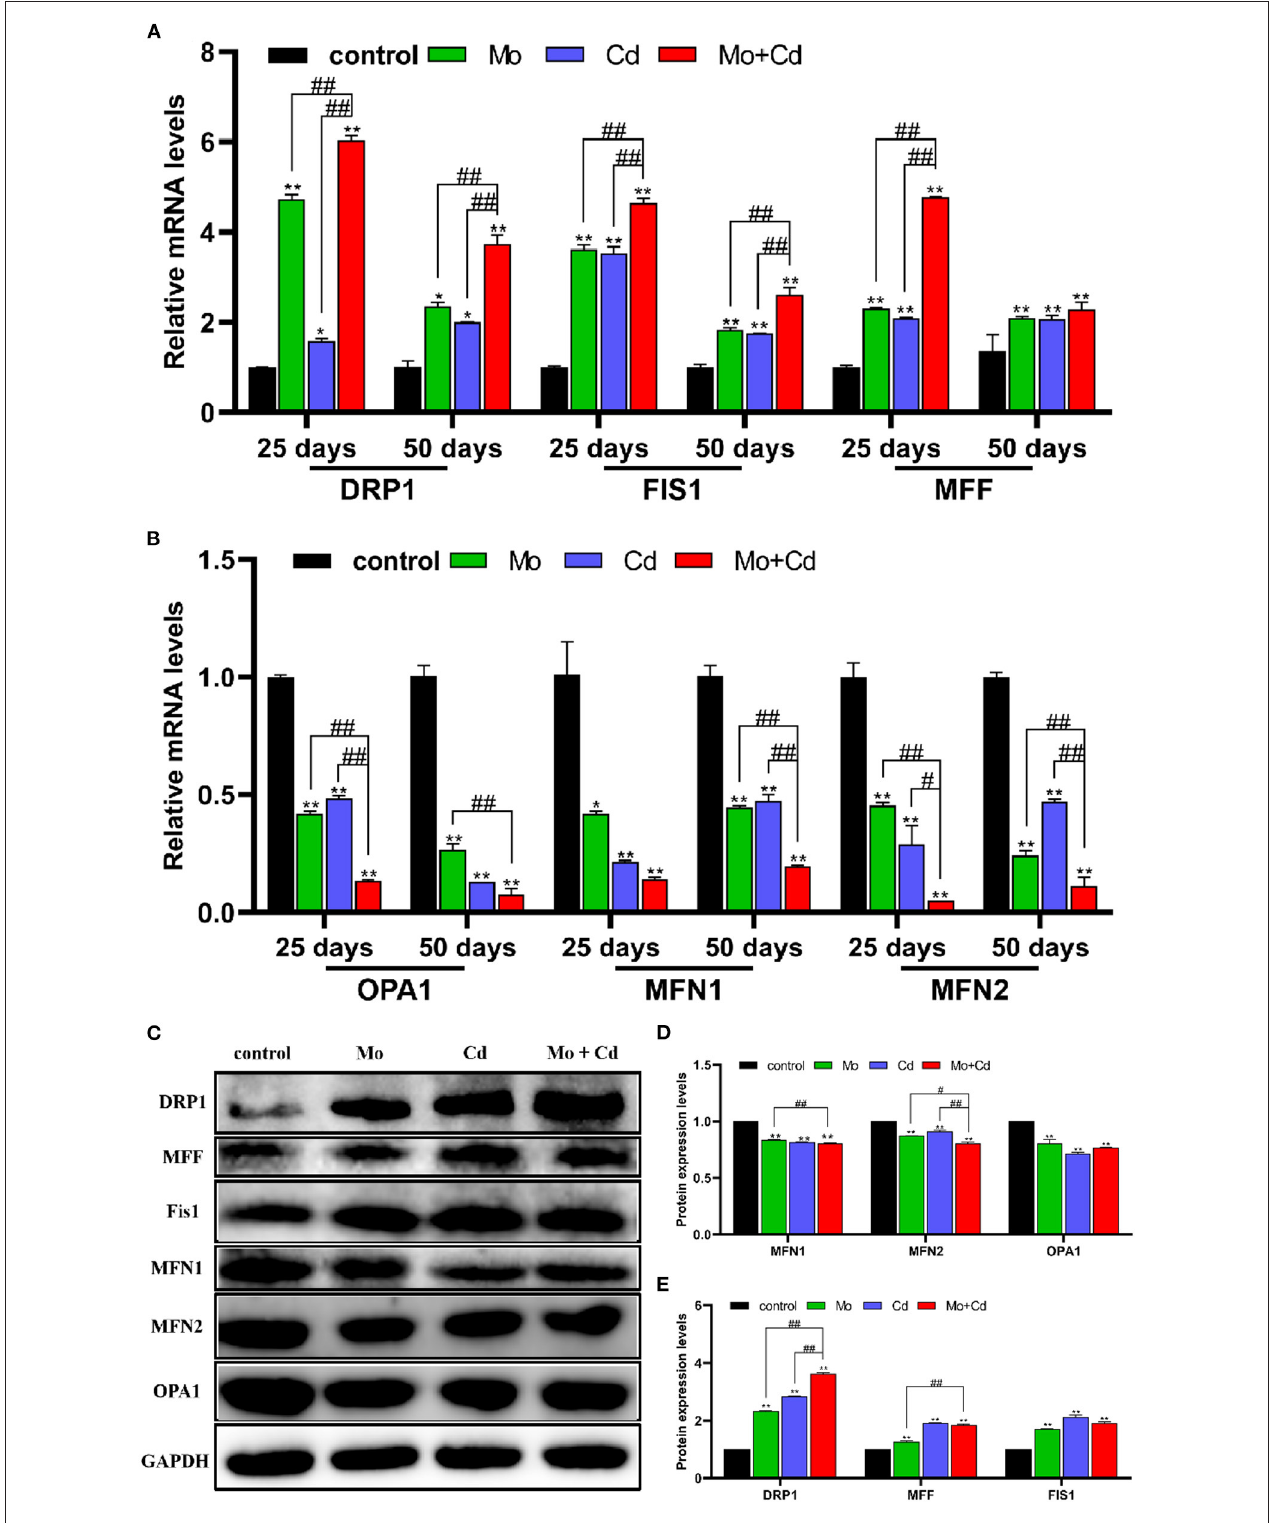
FIGURE 4 | Mo or/and Cd exposure regulated Mitochondrial fusion and fission (mitochondrial dynamics). (A) The mRNA levels of DRP1, MFF and FIS1, (B) The mRNA levels of MFN1, OPA1 and MFN2. (C) The western blot results of DRP1, MFF, FIS1, MFN1, OPA1 and MFN2. (D,E) The quantification of DRP1, MFF, FIS1, MFN1, MFN2, OPA1 and PGC-1 α protein levels. Data are expressed as means ± SD ( n = 6). “*” indicates significant difference compared to the corresponding control (* P < 0.05, ** P < 0.01). “#” indicates statistically significant difference between corresponding groups ( # P < 0.05, ## P <